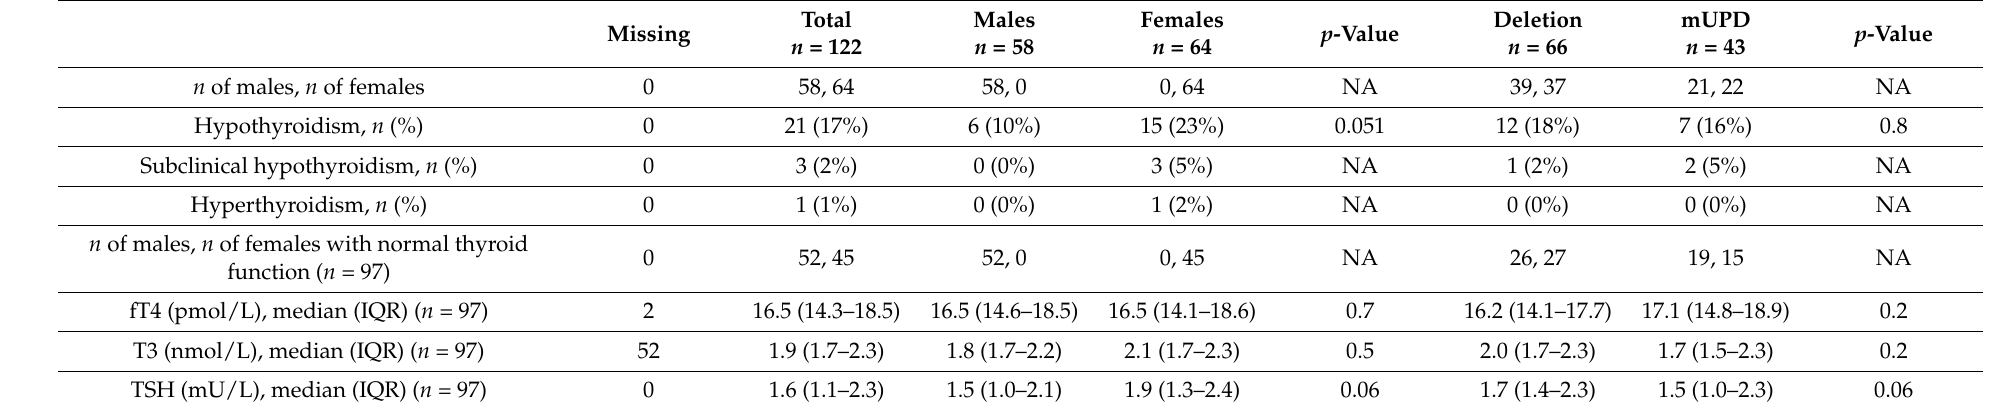
Table 2. Prevalence of hypothyroidism and thyroid hormone levels in 122 patients with PWS (Part 1). Total Males Females Missing n = 122 n = 58